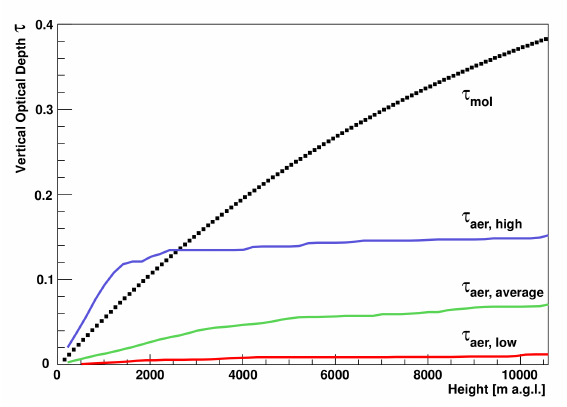
Figure 4. Comparison between a typical average vertical molec- ular optical depth profile (black) and aerosol optical depth pro- files in three di ff erent attenuation conditions (high, average and low).